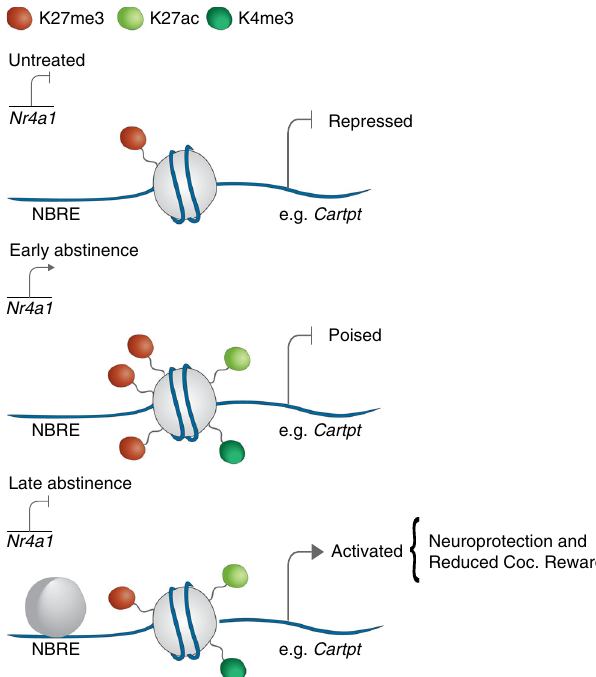
Fig. 6 Mechanism of Nr4a1 activation of homeostatic gene expression. In untreated mice, Cartpt is repressed. During early abstinence, Nr4a1 is activated and Cartpt is repressed by H3K27me3 enrichment but poised for later activation. During late abstinence, Nr4a1 expression returns to baseline, and Cartpt is activated by depletion of H3K27me3 and enrichment of H3K27ac and H3K4me3 via sustained Nr4a1